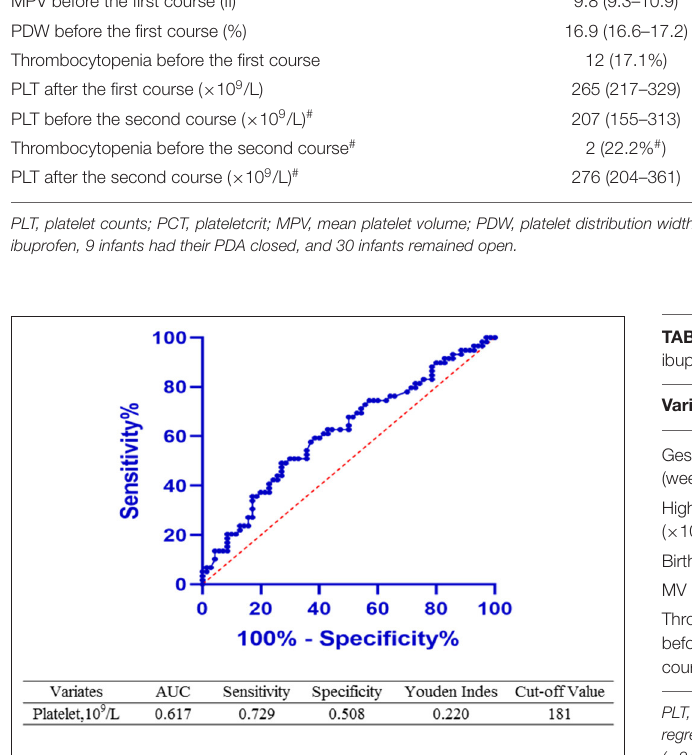
FIGURE 2 | ROC curve and calculation of the cutoff value. A Receiver-operator curve was performed and the cutoff value of the platelet count before the initiation of treatment optimally predicting the closure of PDA was calculated. A platelet count ≥ 181 × 10 9 /L was concluded as the cutoff value with area under the curve (AUC, 0.617); the confidence interval (CI) was 0.483–0.685; sensitivity, 0.729; specificity, 0.508; and Youden index, 0.220.